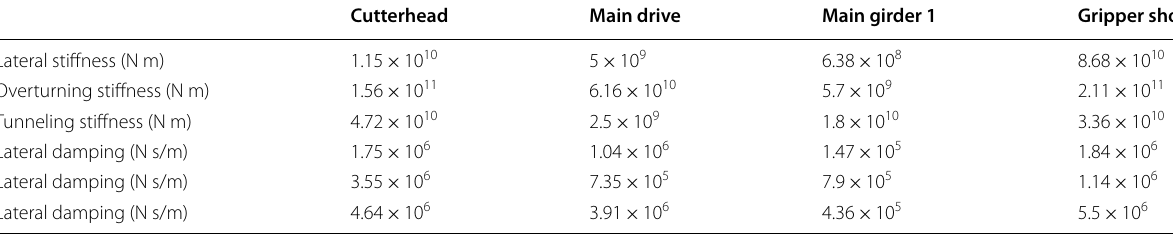
Table 1 Partial stiffness and damping parameters of mainframe